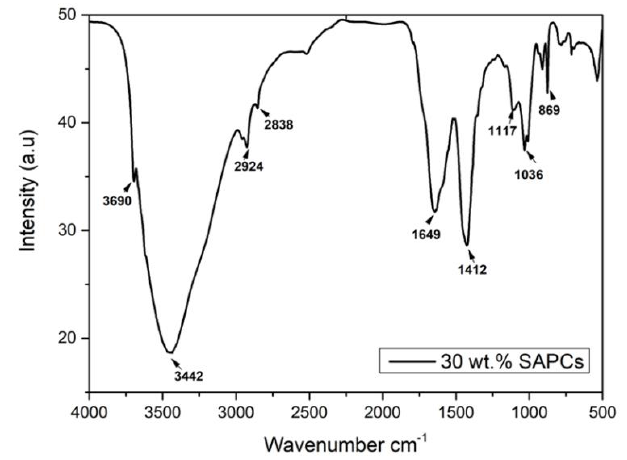
Fig. 1. FTIR- Spectra of superabsorbent polymer composite (SAPCs)